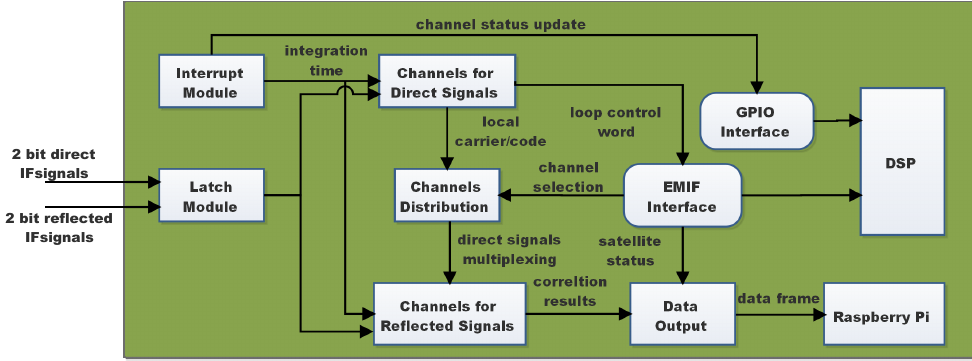
Figure 3. Principle block diagram of